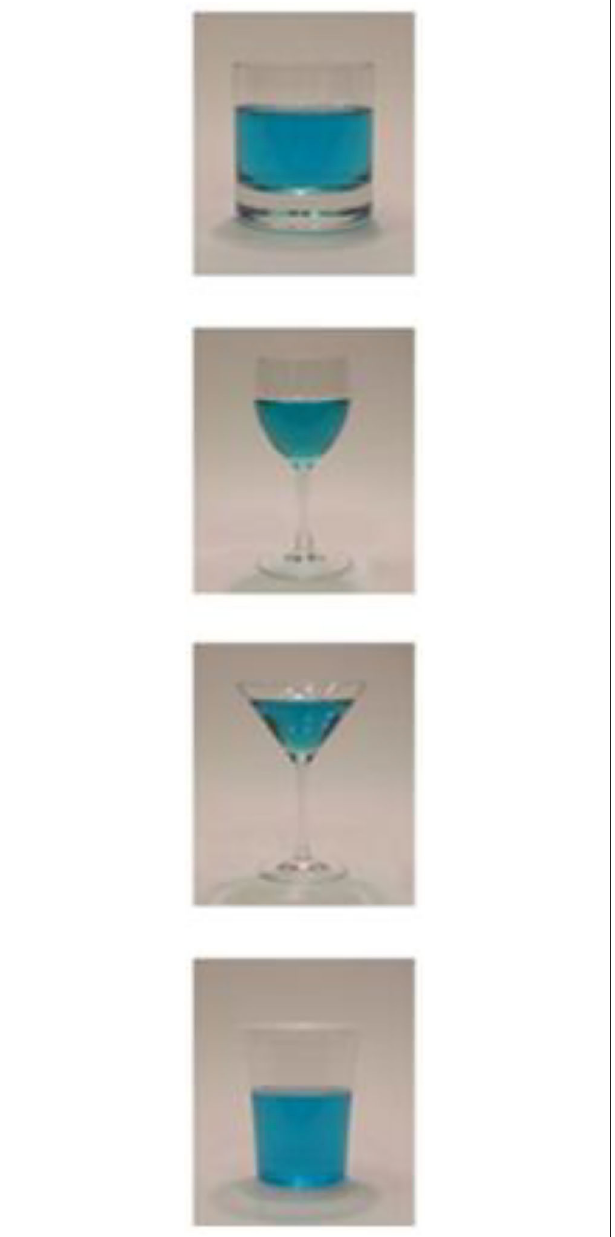
FIGURE 3 | The four different glasses in which colored drinks (having one of seven colors) were presented to participants in a series of cross-cultural studies designed to assess the impact of glassware on the flavor expectations set by colored drinks in a study by Wan et al. (2014a).